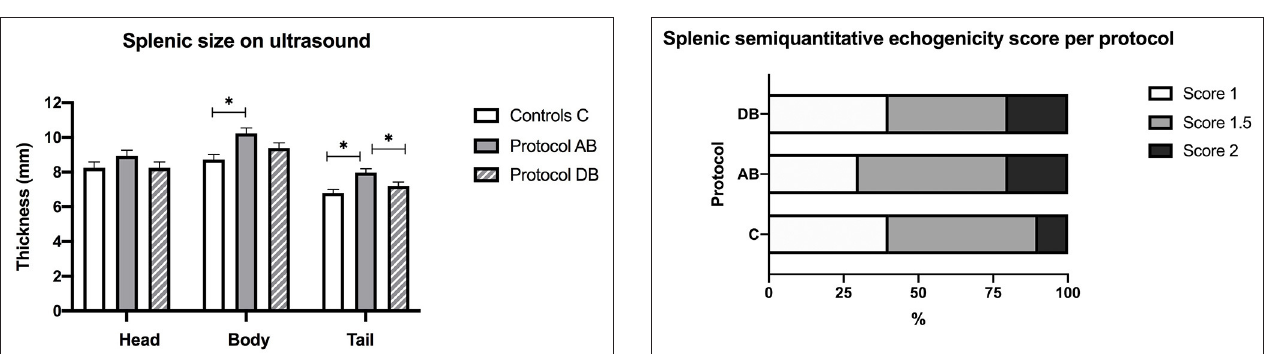
FIGURE 6 | Distribution of splenic semi-quantitative echogenicity scores across the controls C and after the administration of protocols AB and